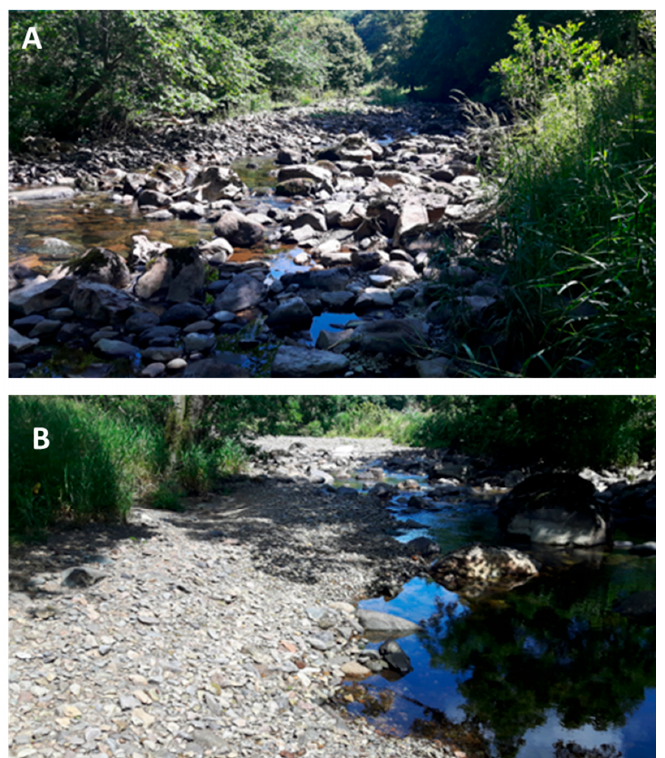
Figure 6. ( A ) Coarse bed armour rapid feature, and ( B ) contrasting active bar and slug sediment, along the channelised upper reaches of the River Caldew study area.